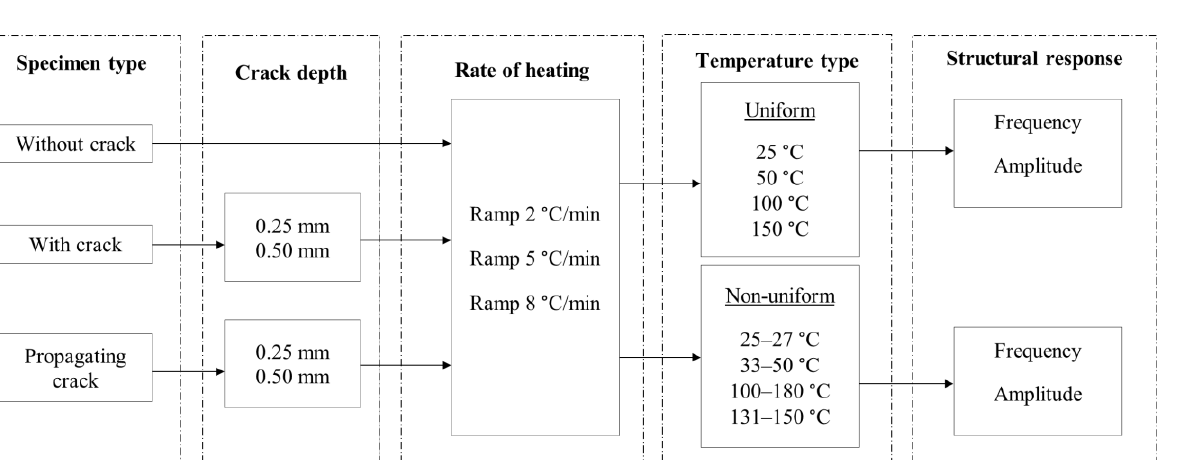
Figure 4. Experiment set-up.